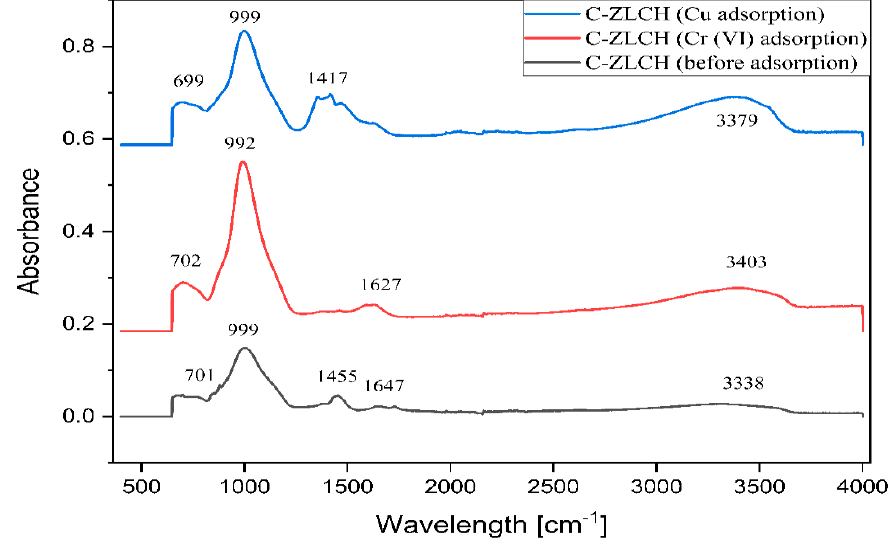
Figure 2. FTIR spectra of C-ZLCH before and after Cu(II) and Cr(VI)